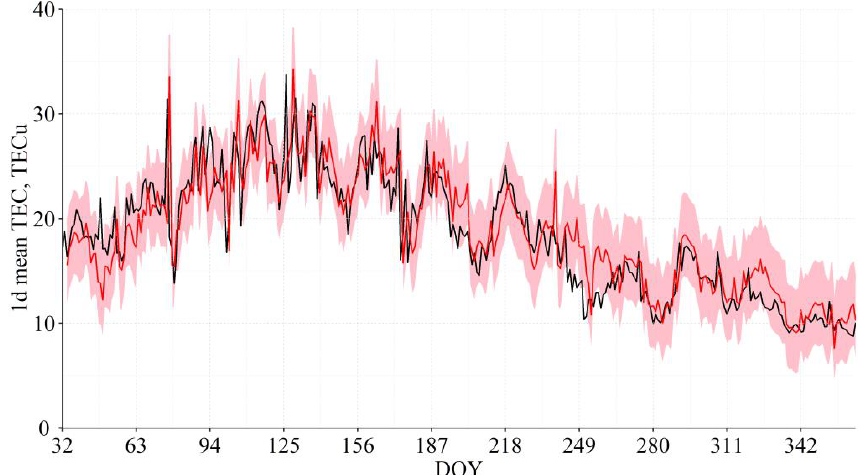
Figure 2. Observed (black) and forecasted using the PCA-MRM (L31, mean.lag1.2) model (red) 1 d mean TEC series for February – December of 2015; pink area shows 90% confidence interval (see Section 5.3).